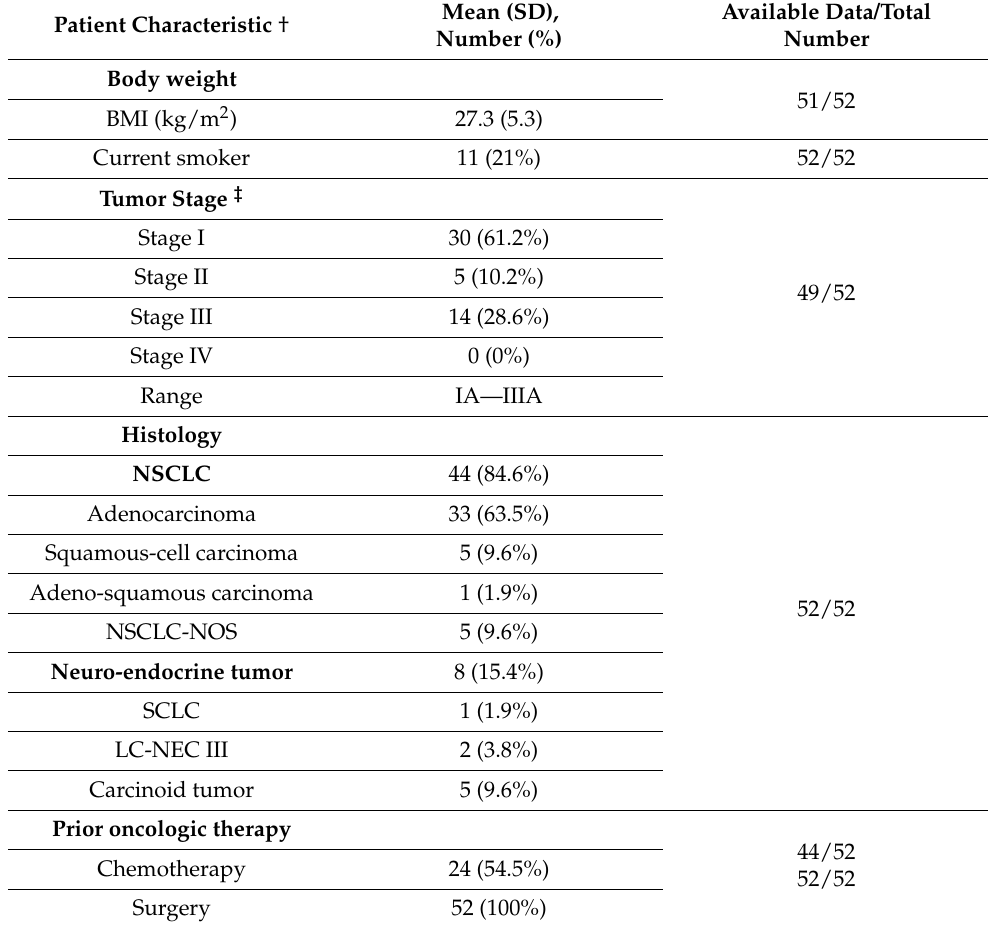
BMI, body mass index; NSCLC, non-small-cell lung cancer; NSCLC-NOS, non-small-cell lung cancer not otherwise specified; SCLC, small-cell lung cancer; LC-NEC III, large-cell neuroendocrine carcinoma grade III; † percentage may not be 100 because of rounding; ‡ staging per UICC Version 8.